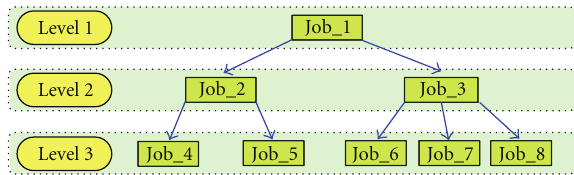
Figure 1: An example of hierarchical structure of MLPS